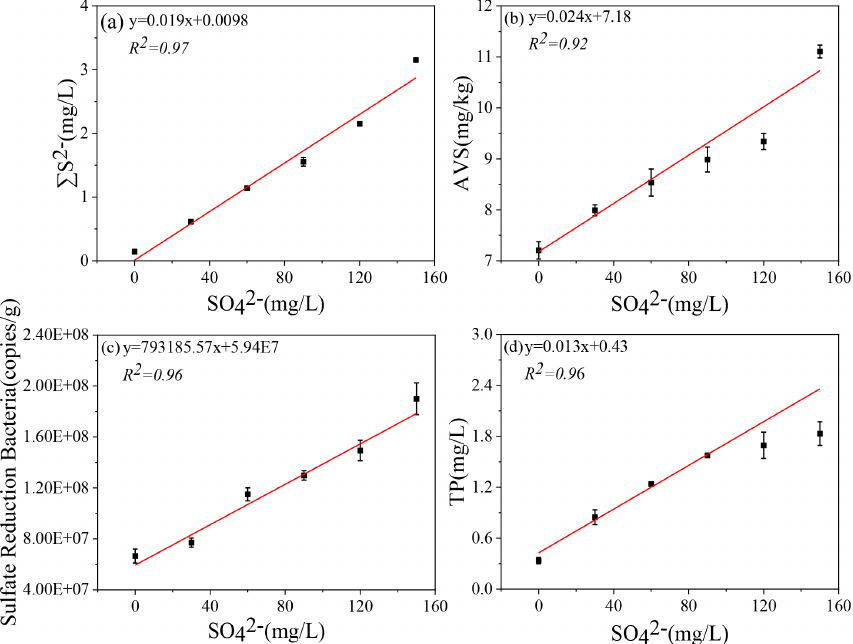
Figure 5. Correlation of initial SO 2 − concentrations with (cid:80) S 2 − (a) , AVS (b) , sulfate-reducing bacteria (SRB) (c) , and TP (d) in the 4 microcosm systems.